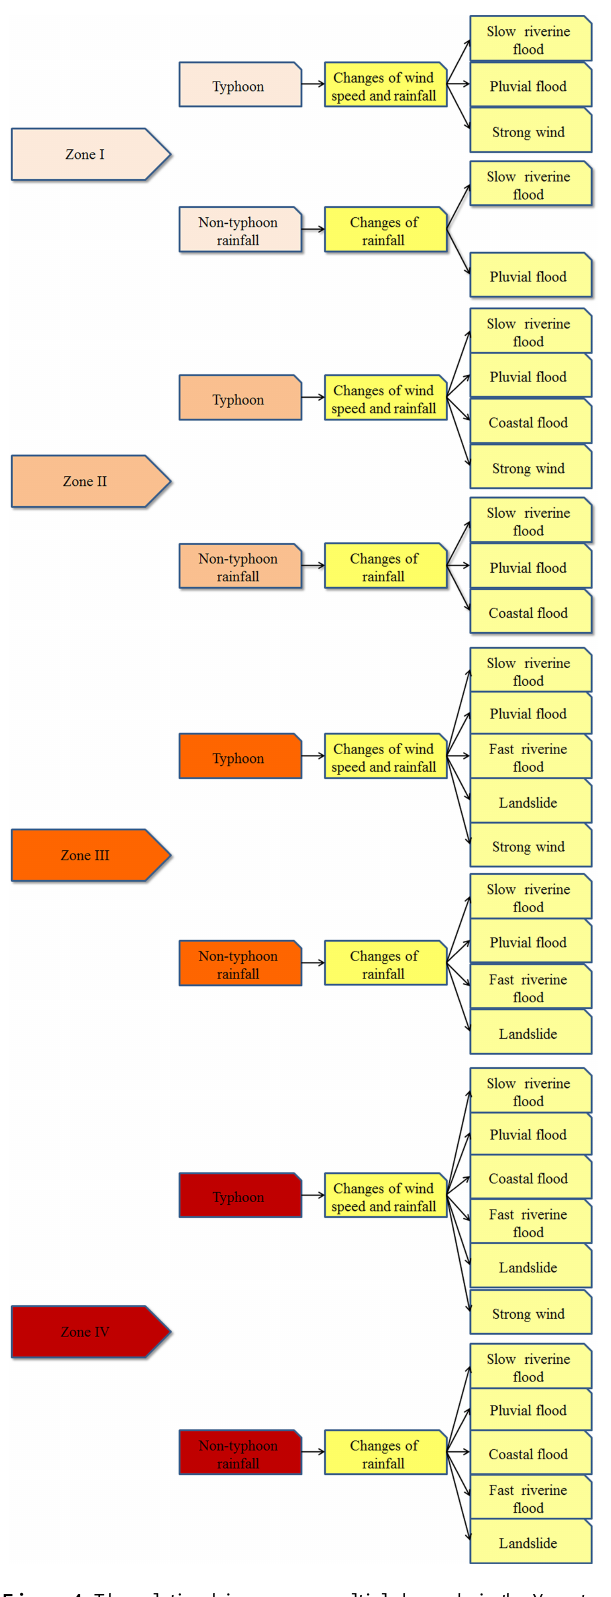
Figure 4. The relationships among multiple hazards in the Yangtze River